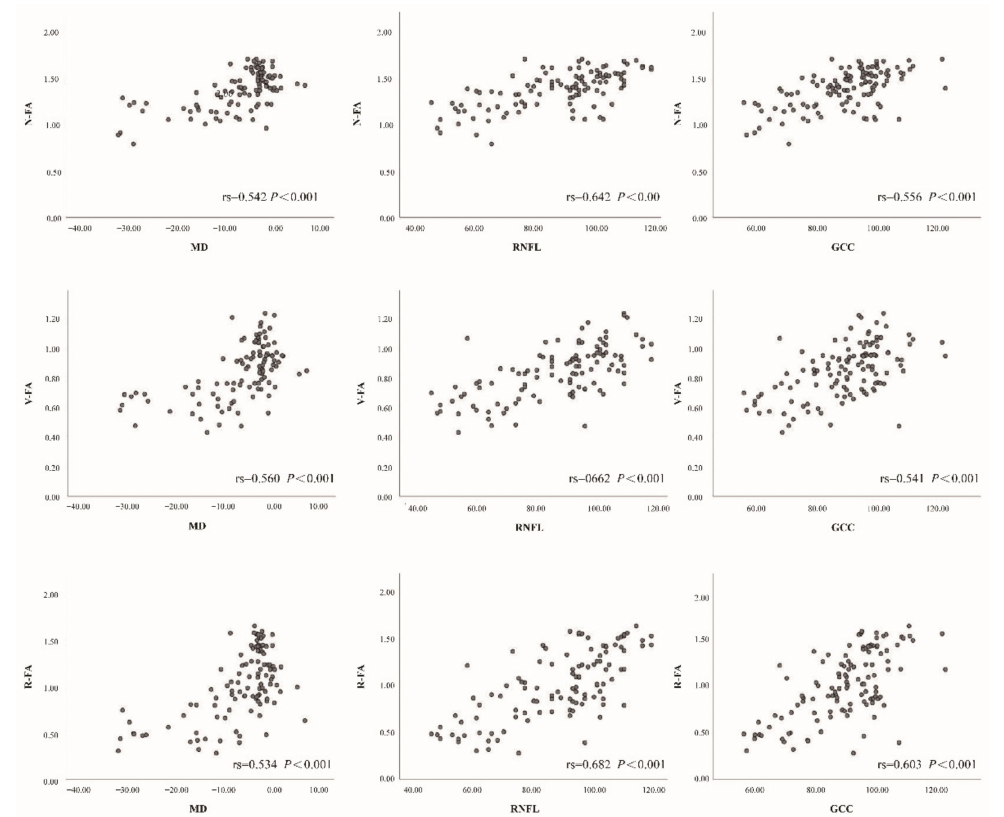
Figure 6. Relationships of flow area of nerve head (NFA), flow area of vitreous (VFA), and flow area of radial peripapillary capillary (VFA) with VF mean deviation (MD), mean retinal nerve fiber layer (RNLF) and ganglion cell complex thickness (GCC) in all